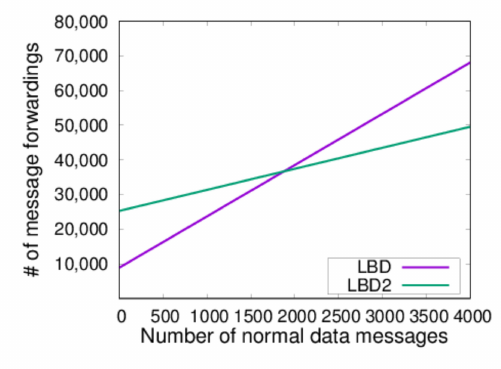
Figure 10. The number of message forwardings versus the number of normal data messages for LBD and